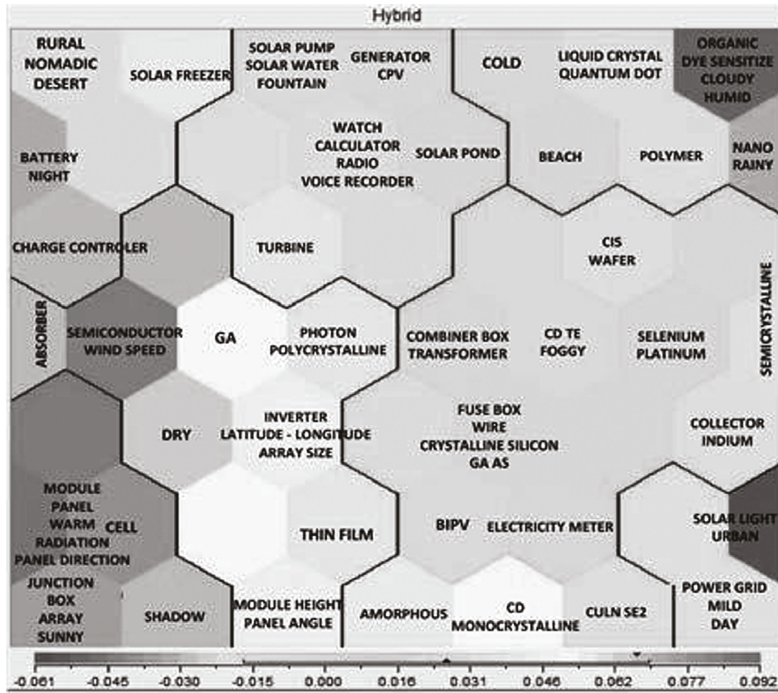
Figure 10: Composite processing feature